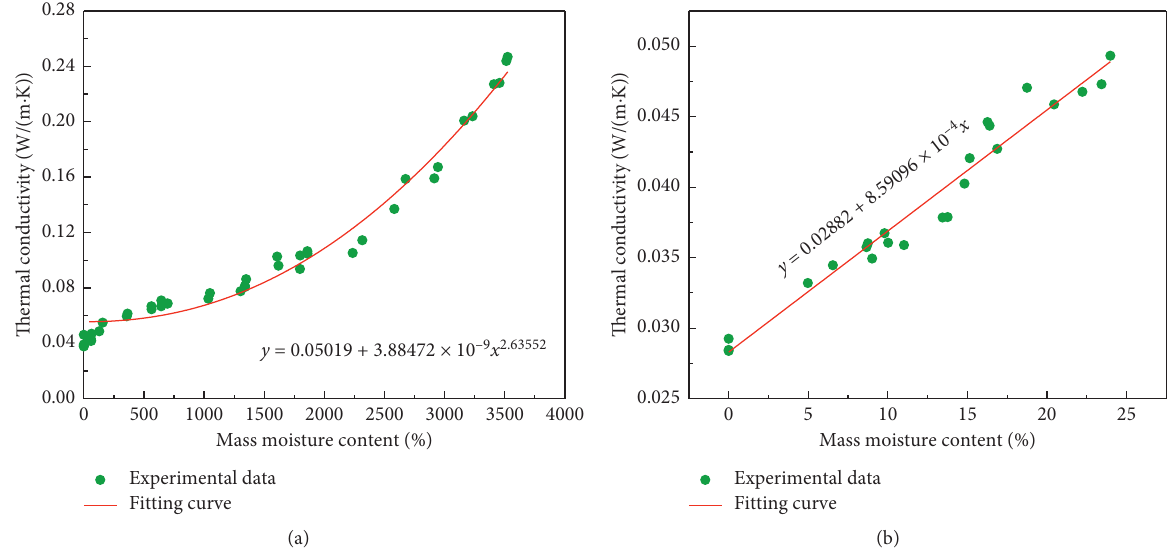
Figure 14: Fitting analysis of the thermal conductivity of different thermal insulation materials. (a) Phenolic insulating board. (b) Peeled polyurethane insulating